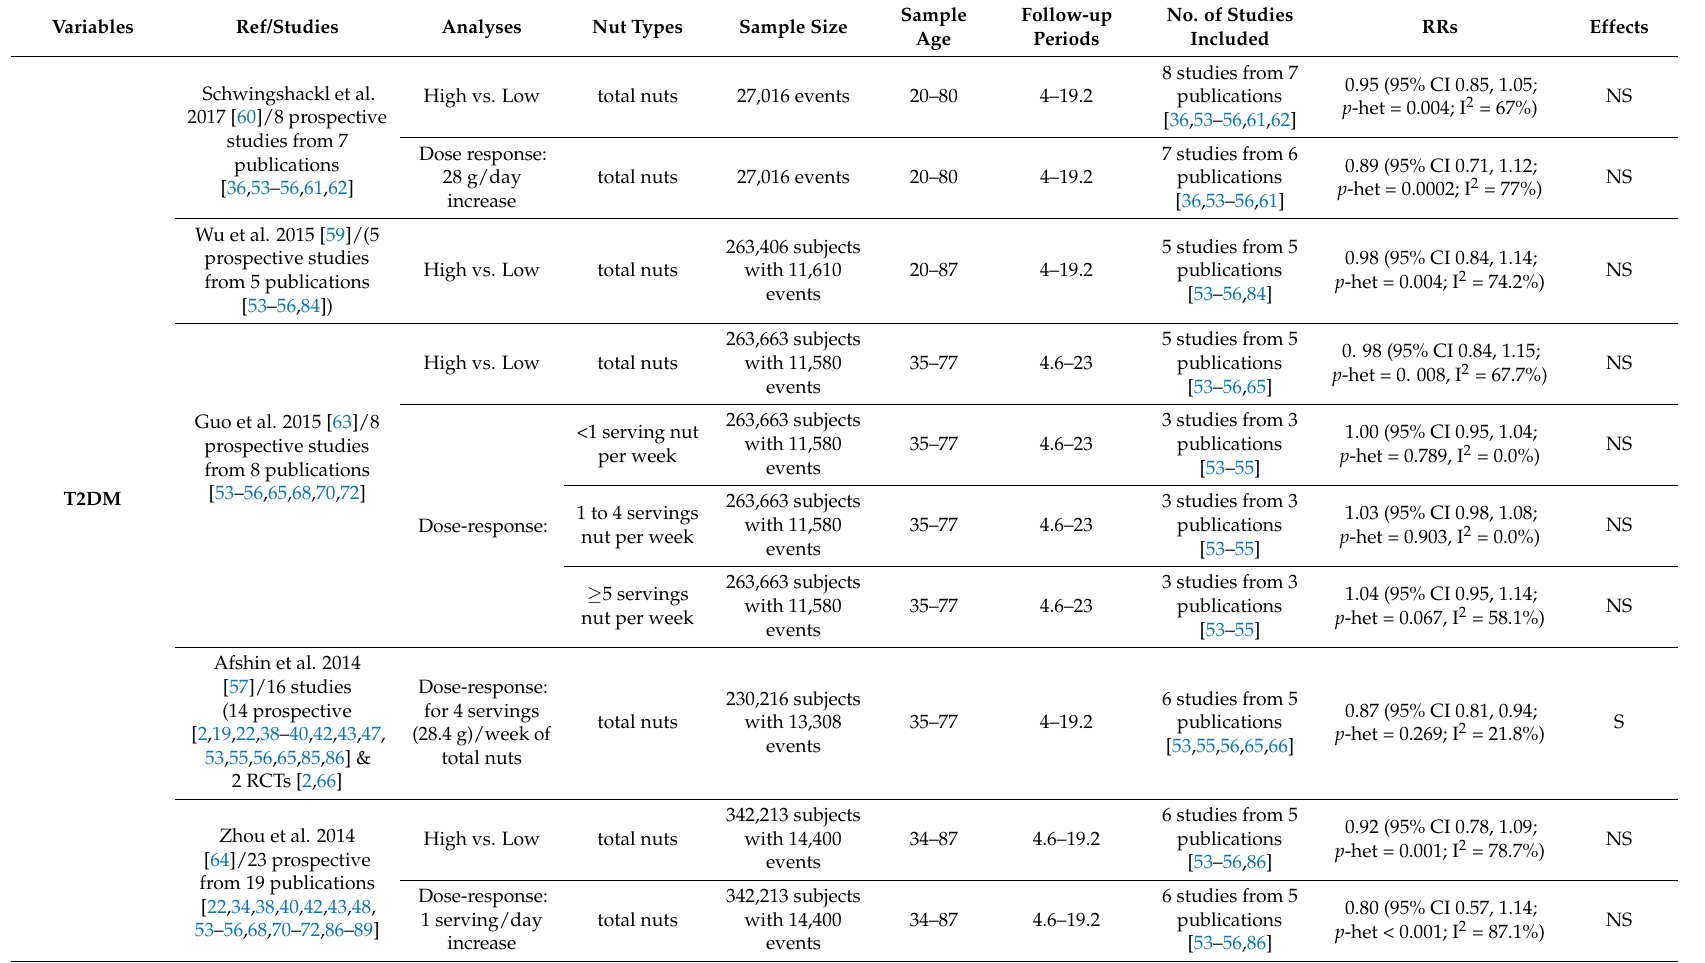
Table 2. Summary of nut consumption and incidence of T2DM, CVD, hypertension, CHD and